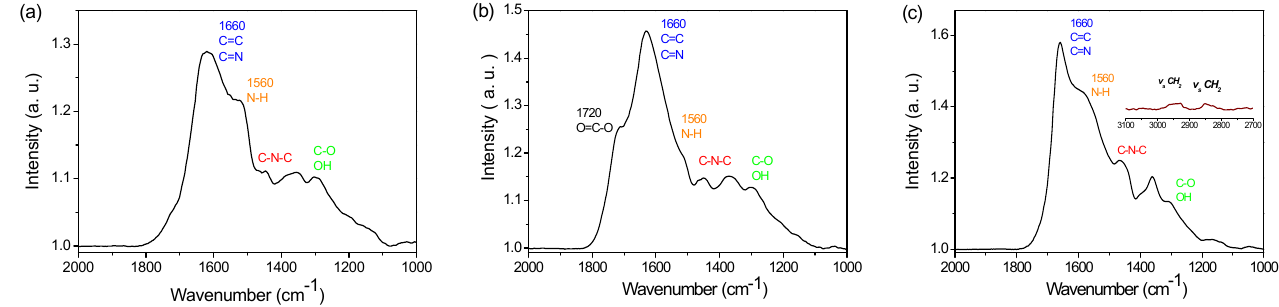
Figure 1. PM-RAIRS spectra of gold surface coated with ( a ) PDA–O 2 , ( b ) PDA–IO 4 − , ( c ) PDA–PEI. PM-RAIRS analyses of the spectrum obtained using sodium periodate are presented in Figure 1b; the spectrum obtained after 5 h revealed the same characteristic groups of PDA observed previously for the PDA–O 2 film at 24 h. However, one can also note that a new peak appears at 1720 cm − 1 , assigned to the stretching vibration of a C=O bond of a carboxylic group. This peak suggests a hyperoxidized state of the PDA, due to the strong oxidizing power of periodate. The material is probably richer in carboxylic groups or quinonoid structures and has undergone a partial loss of carbon [31]. This is in accordance with the known chemistry of periodate, which, when used in excess, can cause o -quinone oxidative cleavage [48]. The spectrum obtained for the PDA–PEI film after 24 h (Figure 1c) is also similar to the spectrum obtained for PDA–O 2 . In addition, IR features are